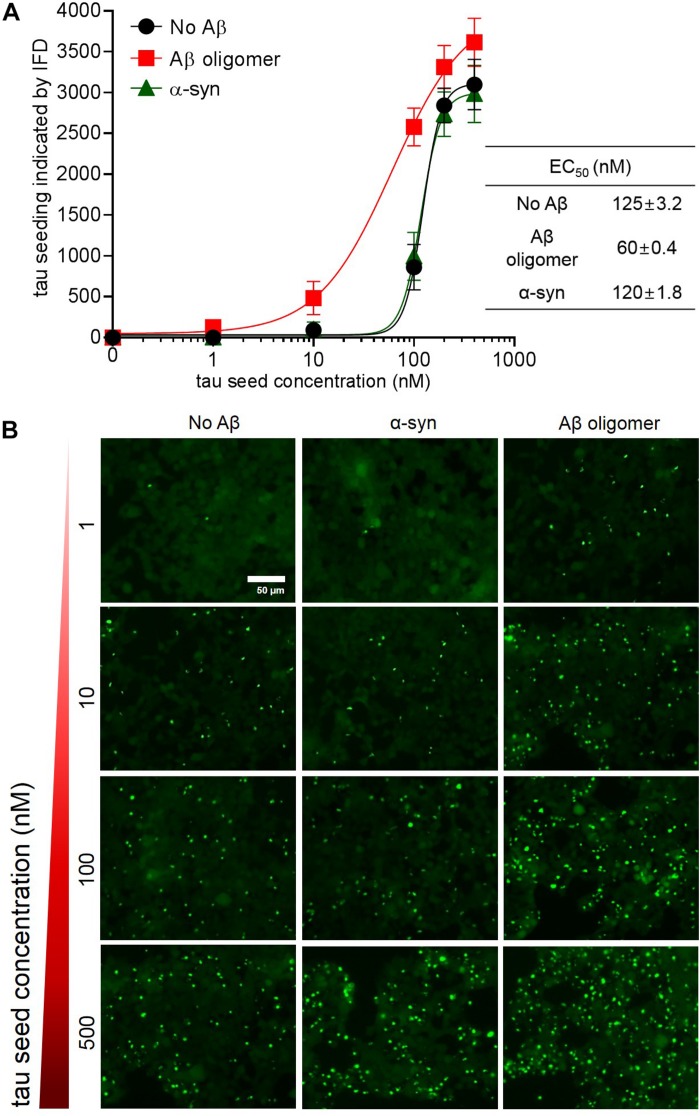
Tau seeding is specifically enhanced by Aβ, not α-synuclein. (A) Tau seeding of biosensor cells pretreated with transduced α-synuclein fibrils or Aβ oligomers as measured by Integrated FRET Density (IFD). (B) Representative fluorescent images of treated tau biosensor cells. The data are presented as mean ± SD (n = 9).